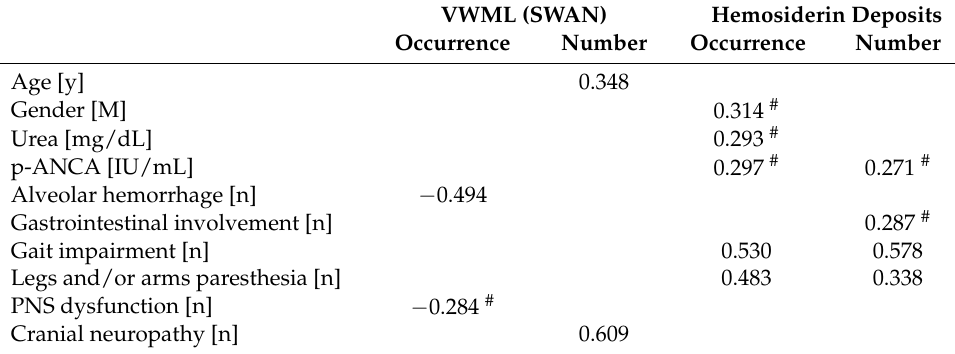
Table 7. Significant correlations of vasogenic